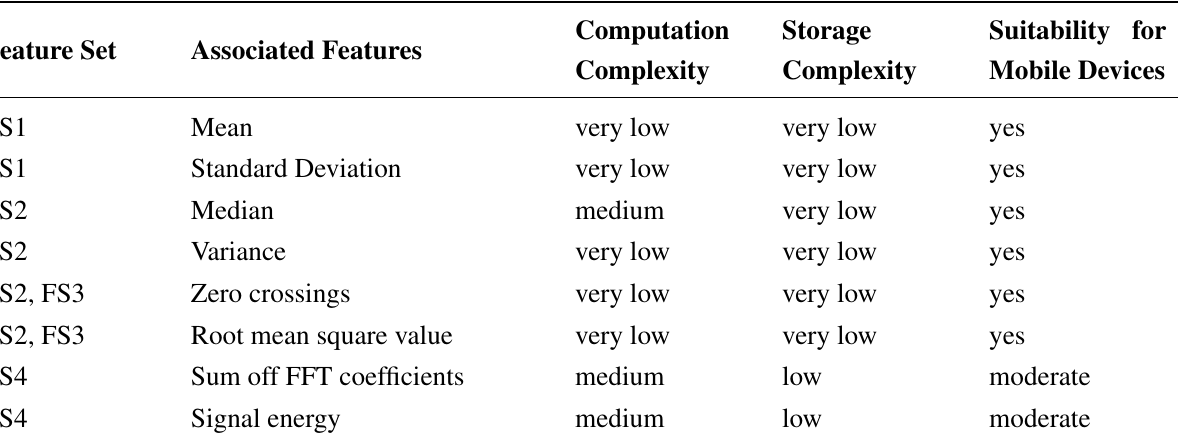
Table 2. Feature